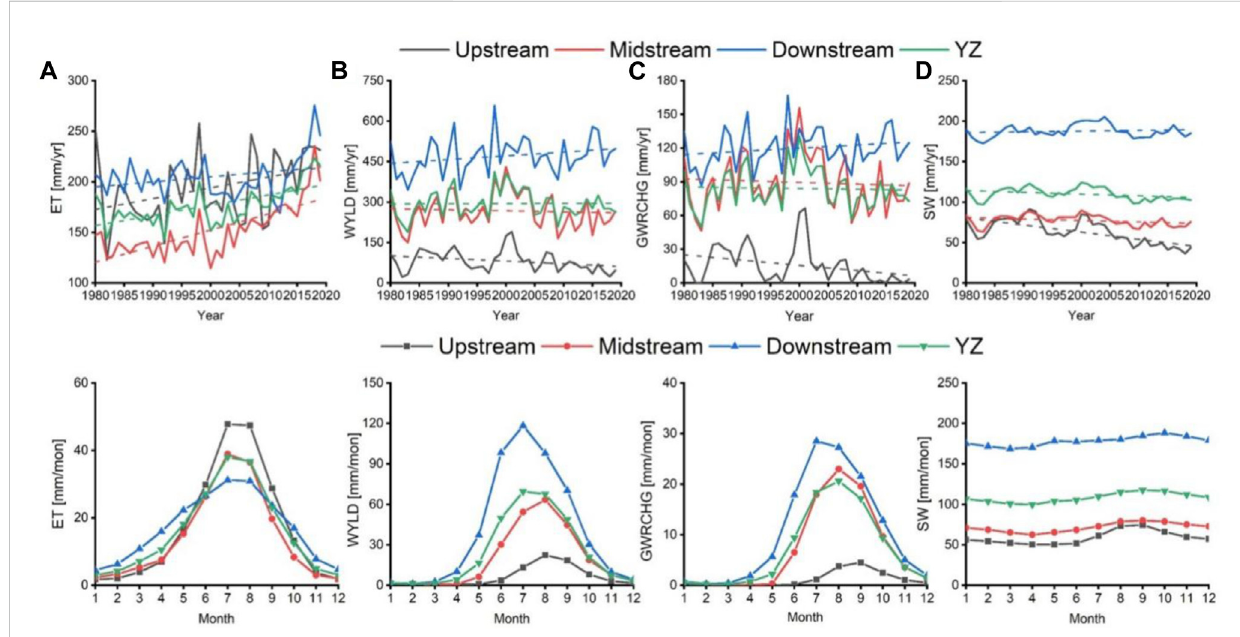
FIGURE 8 Temporal distribution of (A) evaporation (ET), (B) water yield (WYLD), (C) groundwater recharge (GW_RCHG), and (D) soil water content (SW) at annual and monthly scales in the historical period (1980 –